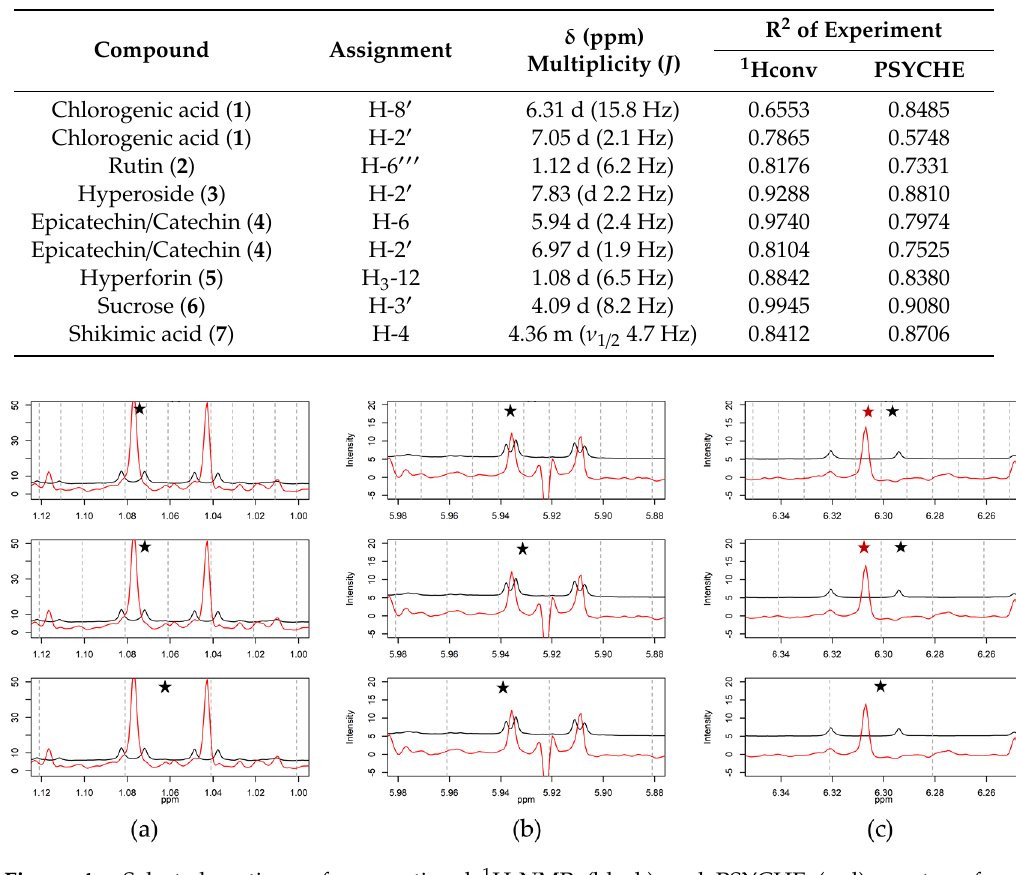
Figure 4. Selected sections of conventional 1 H-NMR (black) and PSYCHE (red) spectra of a representative Hypericum perforatum sample evaluated with different bin sizes to display signals at: ( a ) 1.08 ppm (d, 6.5 Hz) H 3 -12 of hyperforin ( 5 ); ( b ) 5.94 ppm (d, 2.4 Hz) H-6 of epicatechin /